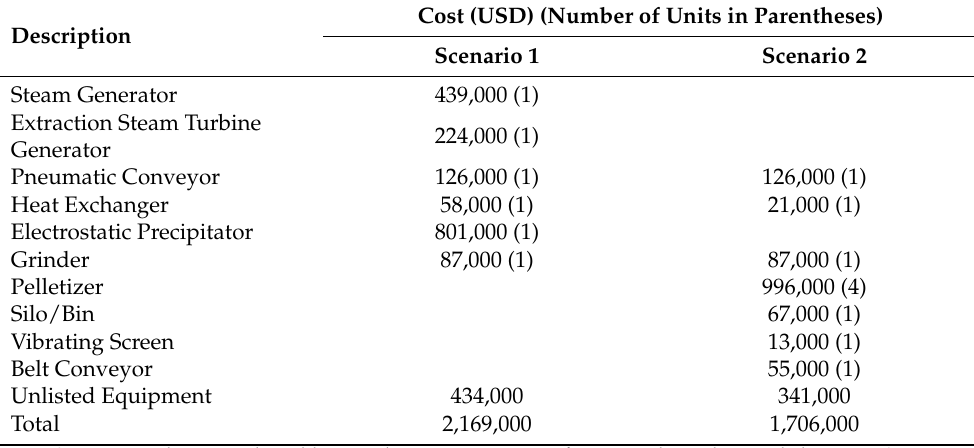
Table 1. Major equipment costs (2020 prices in USD) for Scenarios 1 and